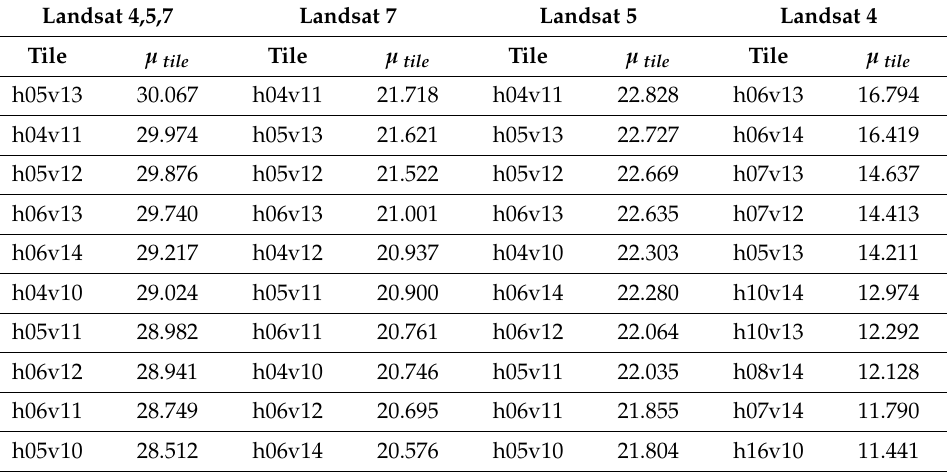
Table 2. The ten most observed CONUS cloud-free ARD tiles over the 36 year study period (red outlined in Figure